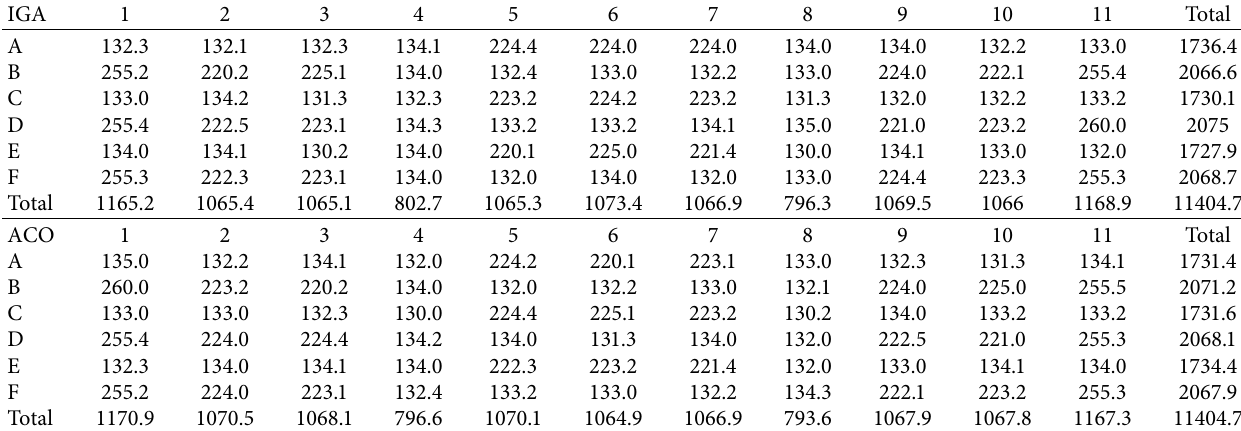
Table 4: Arrangement of hammerheads and fenders of IGA and ACO